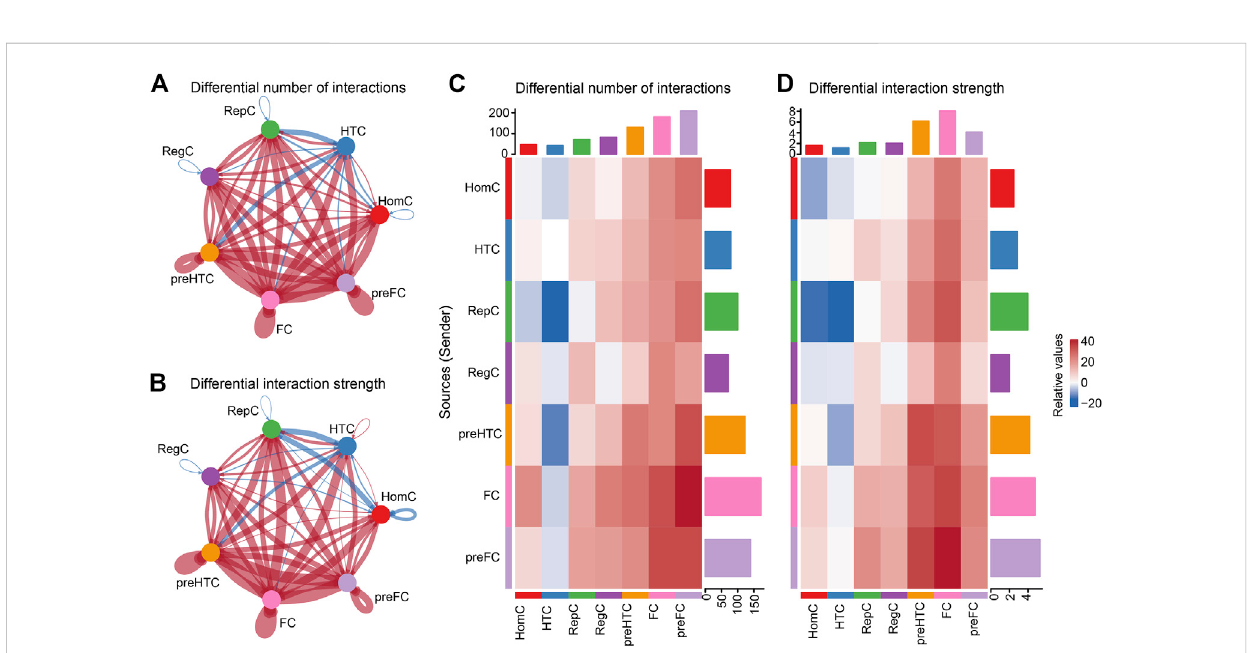
FIGURE 4 Inferencesofcell – cellcommunicationbyCellChatrevealingtheglobalsignalingchangesbetweentheintactanddamagedcartilagesamples. (A – B) Circular plots of the cellular interaction number (A) and interaction strength (B) between each chondrocyte subtype. The blue line indicates a decreased communication number in the damaged cartilage compared to that in the intact cartilage, while the red line indicates an increased communication number in the damaged cartilage. (C – D) Heat maps of the cellular interaction number (C) and interaction strength (D) between chondrocyte subtypes. The vertical axis represents the signal sender and the horizontal axis represents the signal receiver. The blue column indicates decreased communication in the damaged cartilage compared to that in the intact cartilage, while red indicates increased communication. The upper and right columns show the relative values of the interaction number and strength,